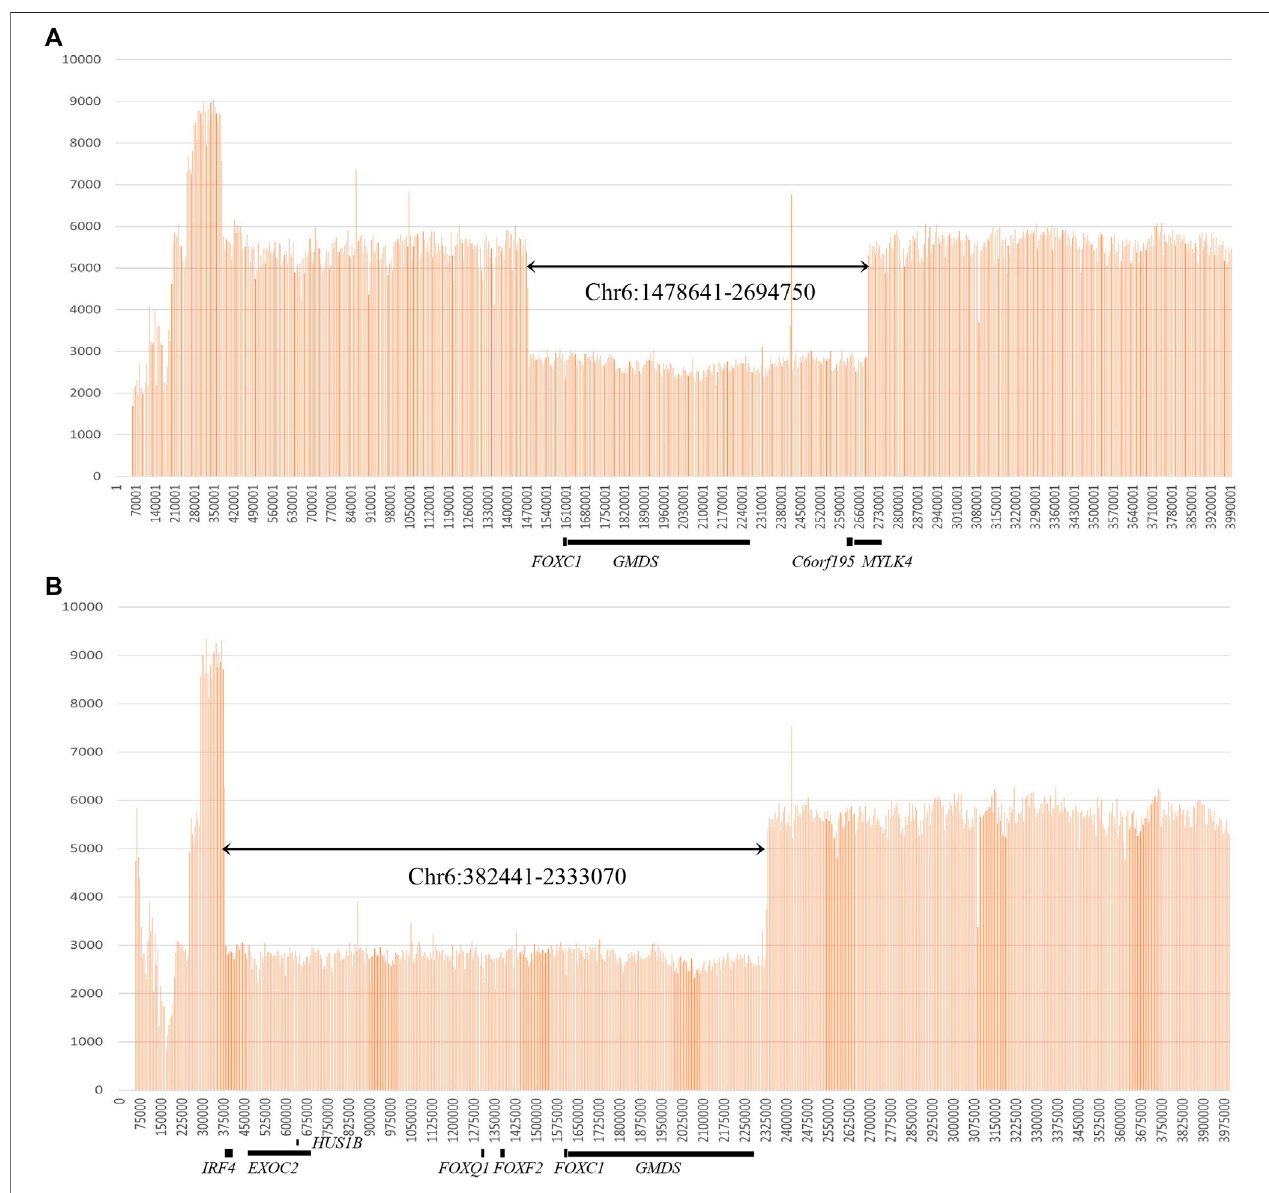
FIGURE 2 | Gross deletions identi fi ed by whole-genome sequencing. (A) Genome sequencing read depth at the gross deletion (chr6:1478641-2694750) for patient No. 20. (B) Genome sequencing read depth at the gross deletion (chr6: 382441-2333070) for patient No.